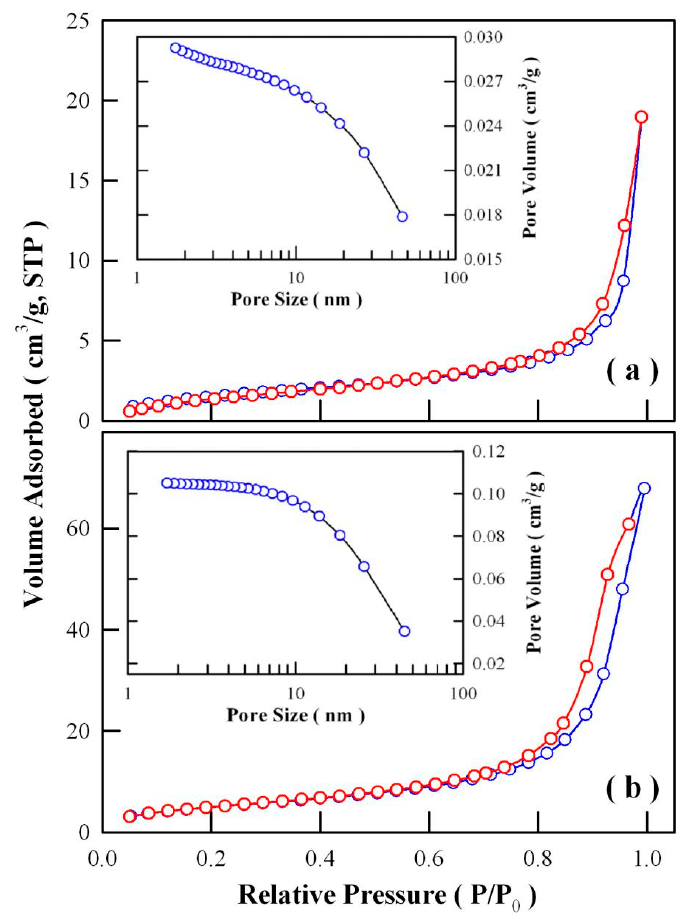
Figure 13. N 2 adsorption and desorption isotherms of ZnWO 4 nanoplates ( a ) and ZnWO 4 nanoparticles ( b ). The inset shows the pore size distributions of ZnWO 4 nanoplates and